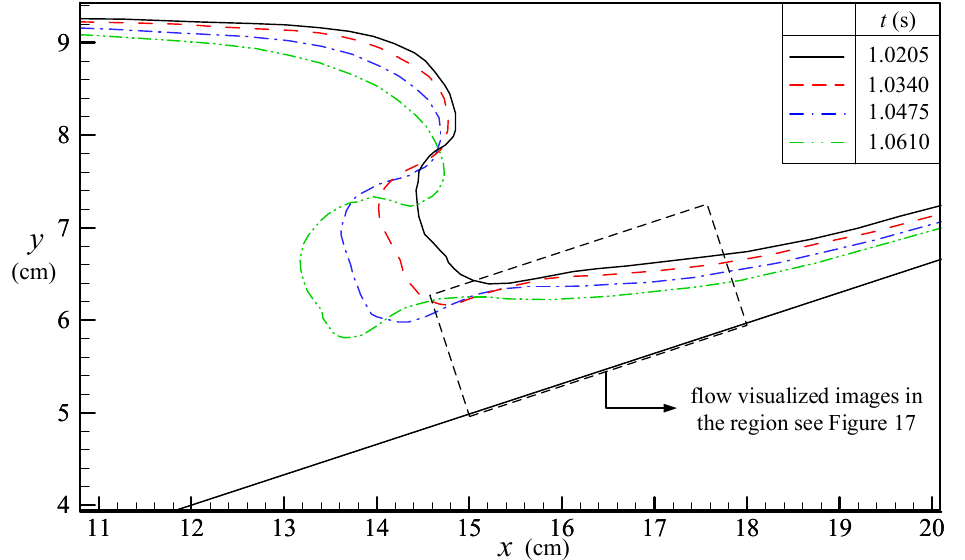
Figure 16 . The free surface profiles obtained at t = 1.0205, 1.0340, 1.0475 and 1.0610 s. Figure 16. The free surface profiles obtained at t = 1.0205, 1.0340, 1.0475 and 1.0610